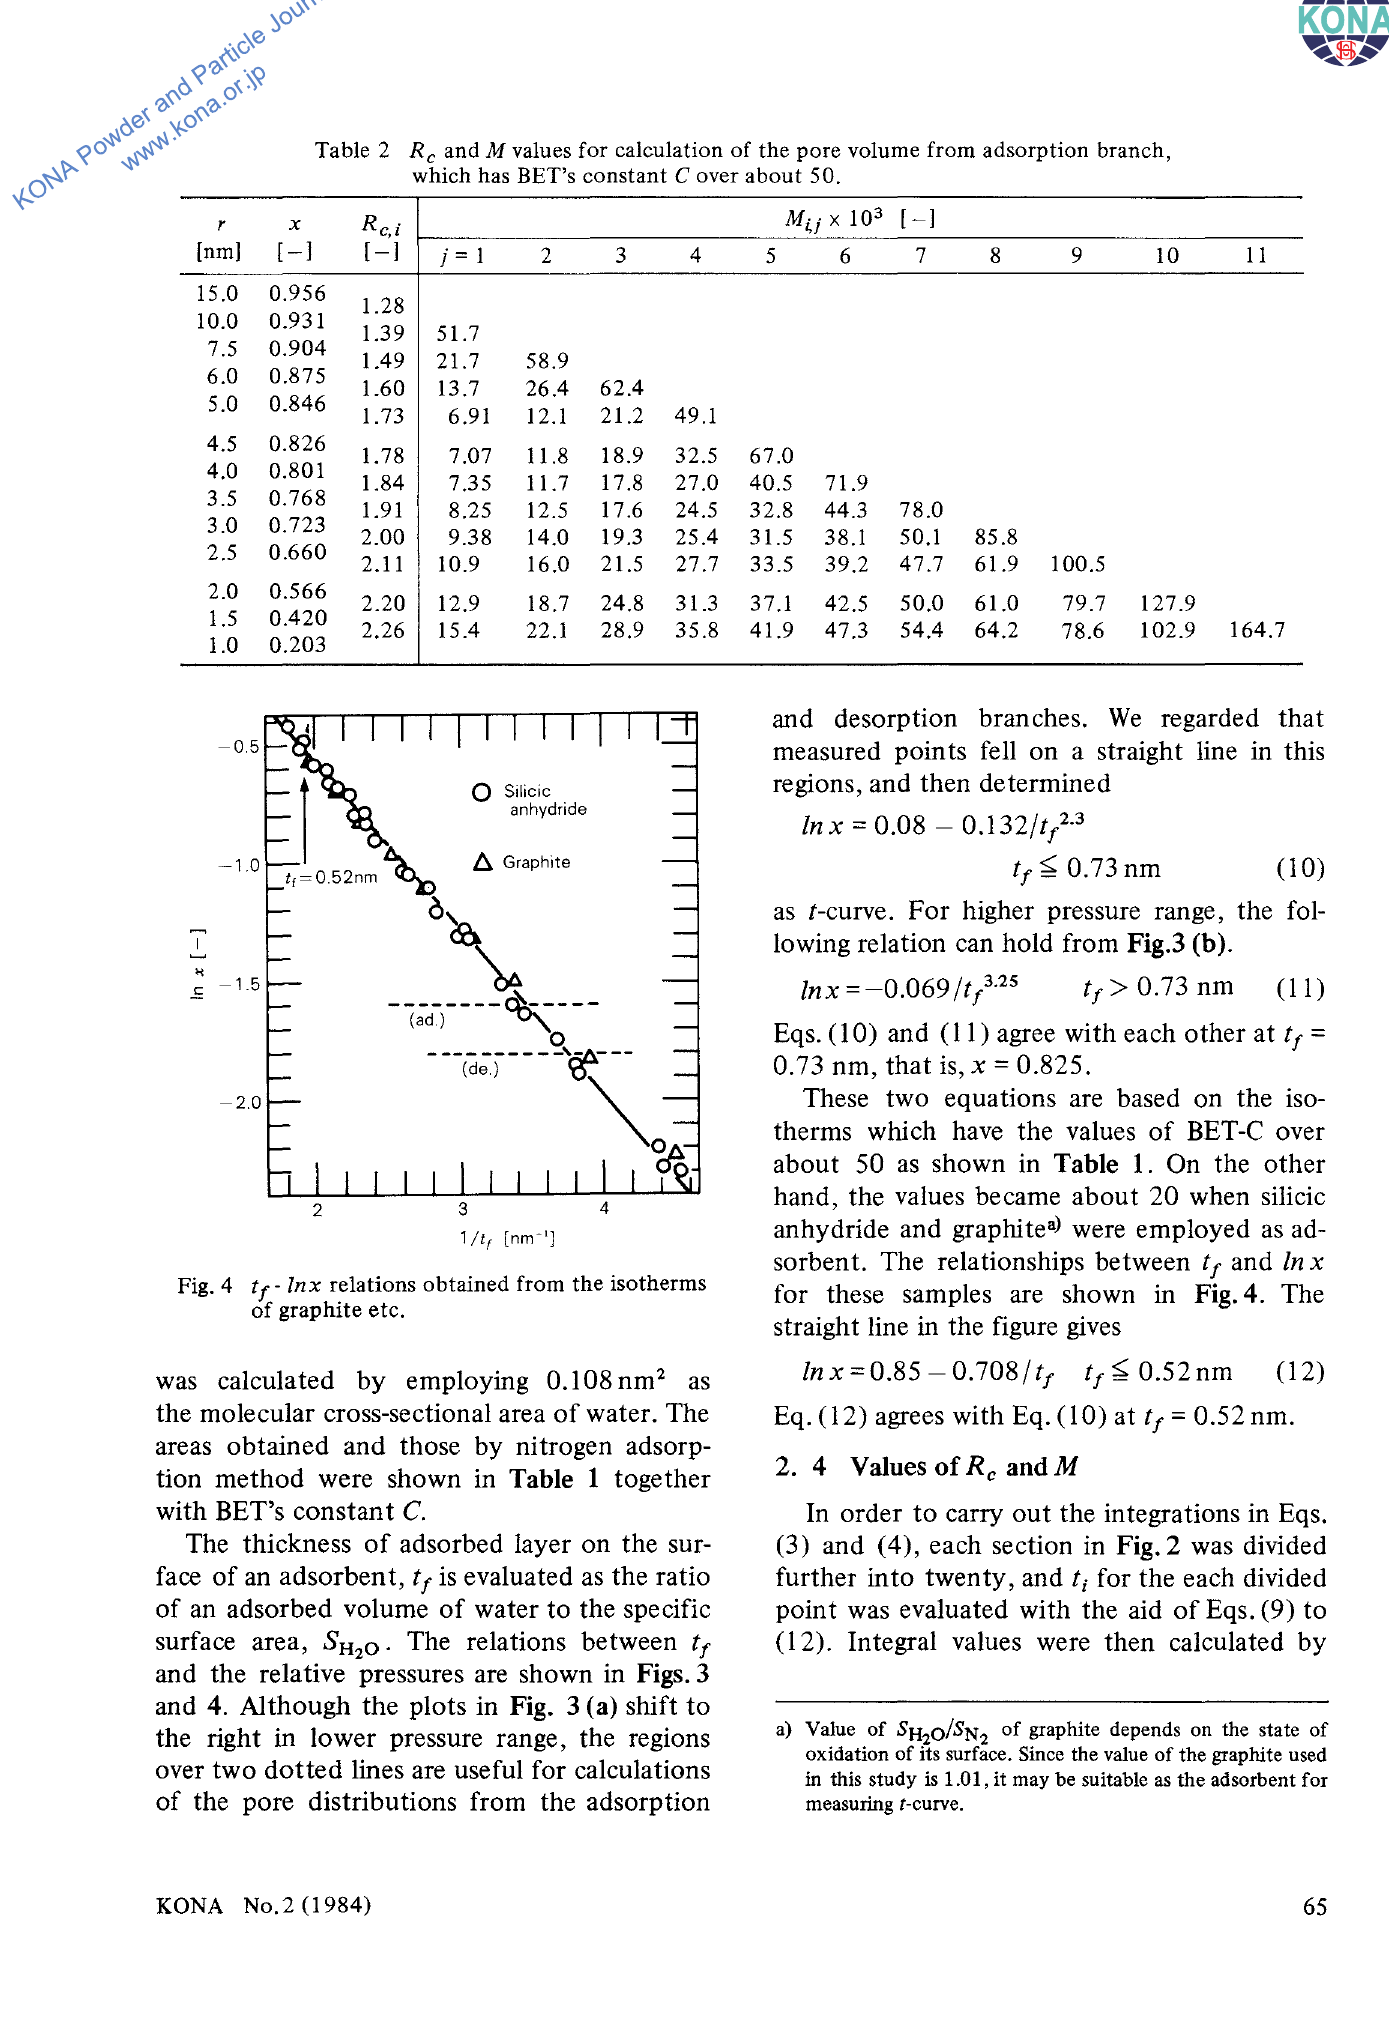
Fig. 4 tr lnx relations obtained from the isotherms of graphite